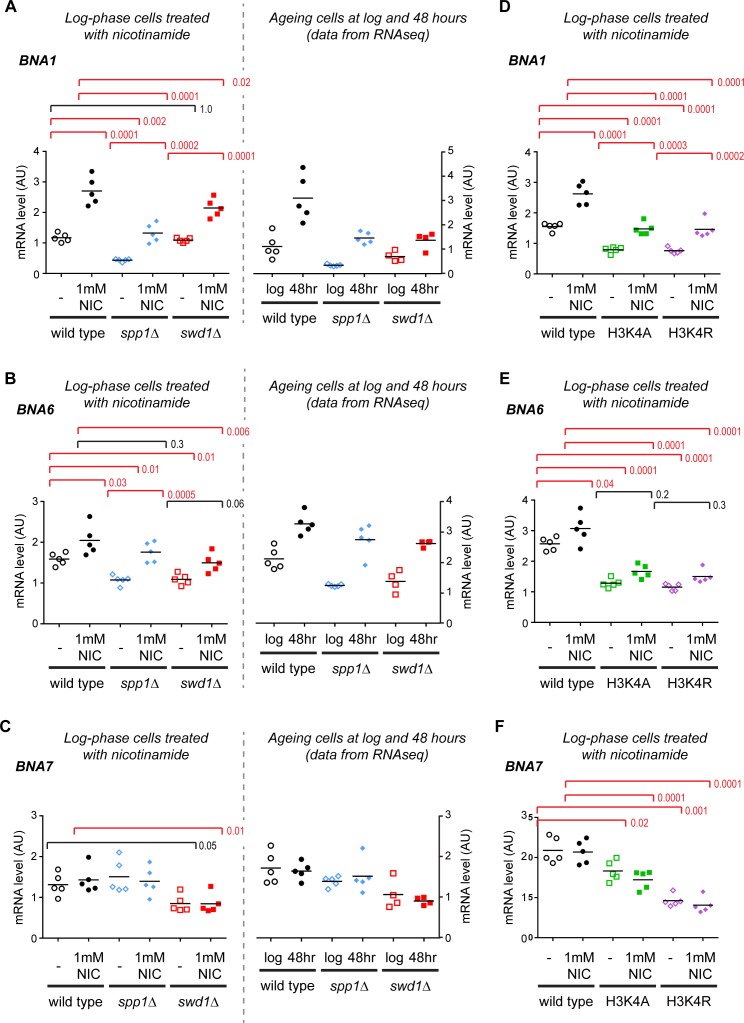
Supplement to validation of gene expression differences in COMPASS mutants.(A–F) Quantification of BNA gene induction by northern blot for BNA1, BNA6 and BNA7, performed as in Figure 3C.